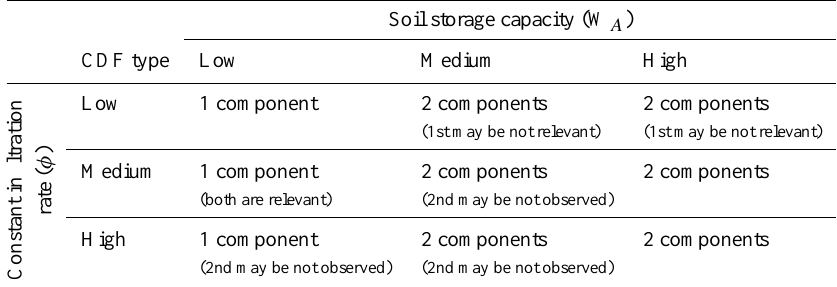
Table 2. Expected basin behaviour, in terms of presence and weight of the two components, based on a broad classification of the different thresholds φ and W A